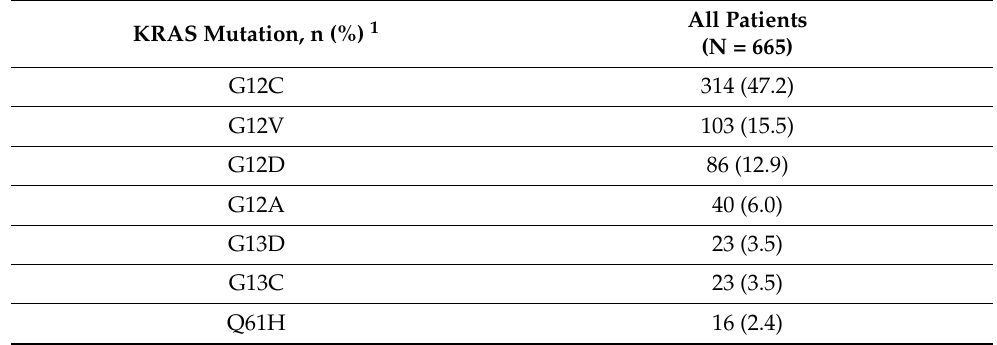
Figure 1. The study population. 1 Patients were tested between January 2017 and October 2021. 2 Table 1. Occurrence of different KRAS mutations in 2495 NSCLC Other KRAS mutations are shown in Table 1. 3 Patients with NSCLC in locally advanced or meta- static tumor stage.